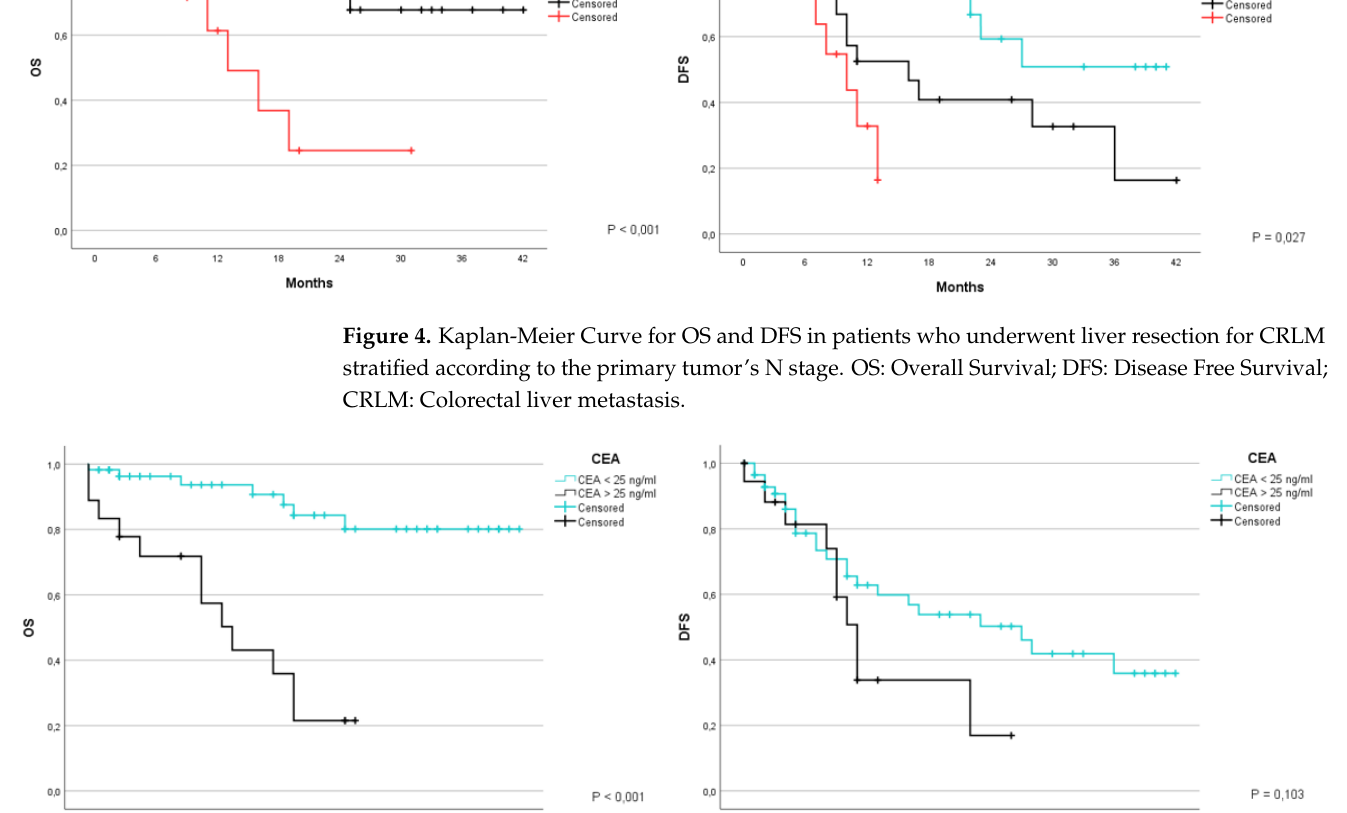
Figure 5. Kaplan-Meier Curve for OS and DFS in patients who underwent liver resection for CRLM stratified according to CEA values. OS: Overall Survival; DFS: Disease Free Survival; CRLM: Colorectal liver metastasis.CEA carcinoembryonic antigen.